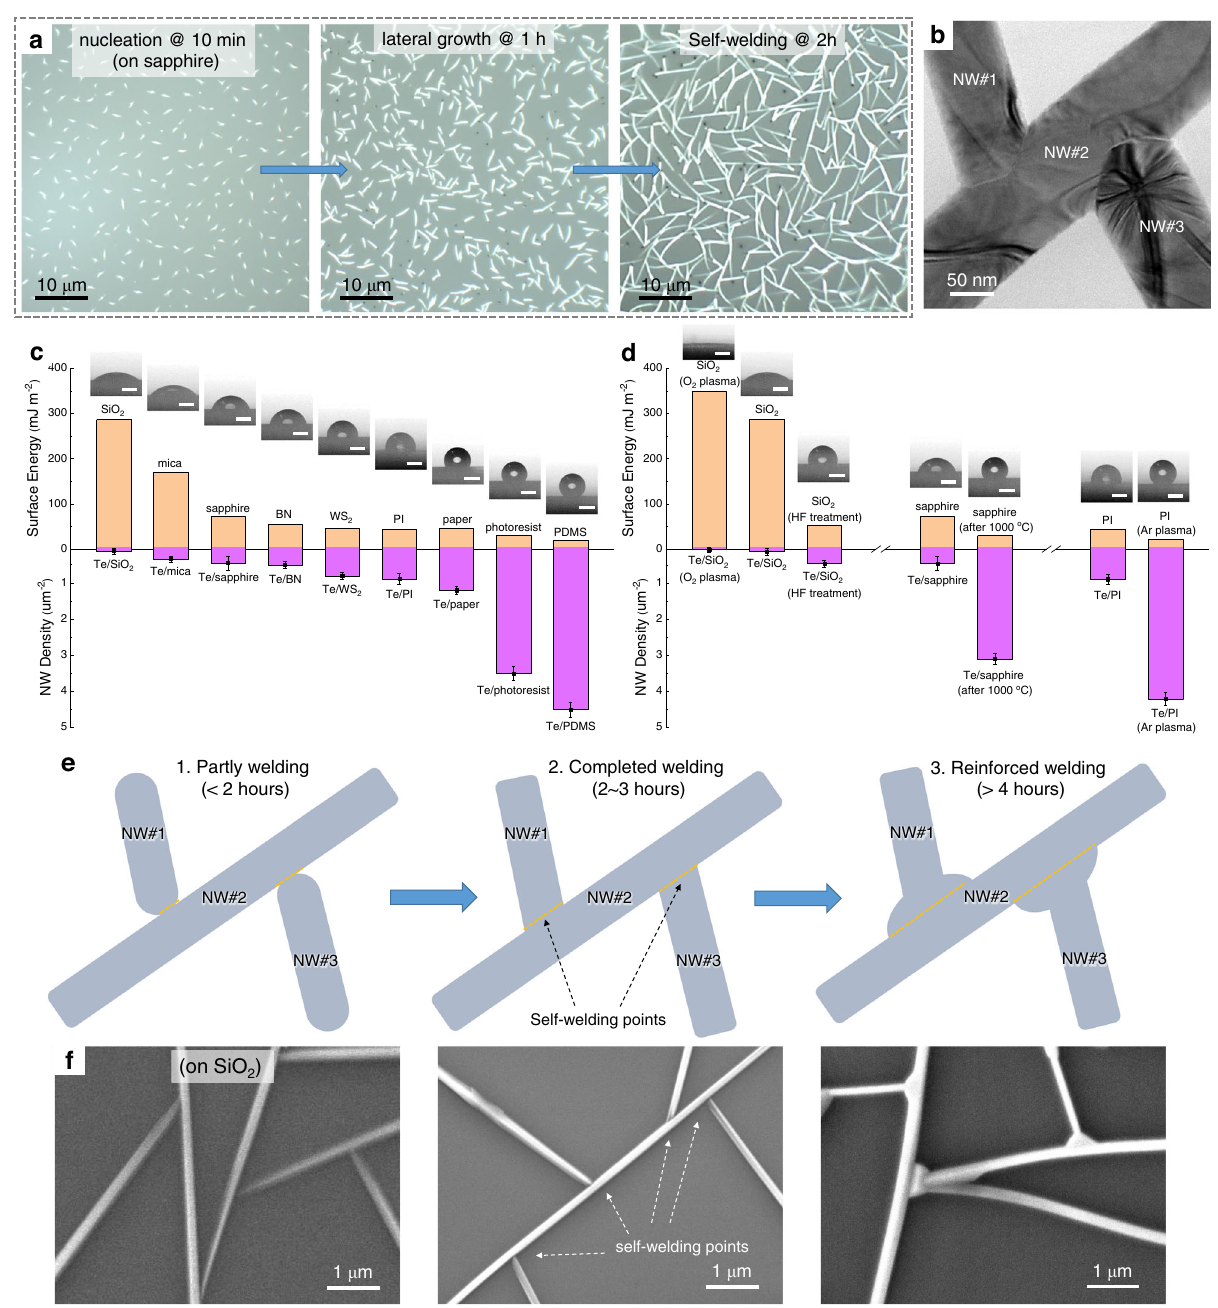
Fig. 2 | Te nanomesh growth. a Optical images of Te nanomeshes grown on sapphire with different growth durations, showing nucleation, lateral growth, and self-welding steps. b Transmission electron microscopy (TEM) images of Te nanomeshes with distinct self-welding regions. c Surface energies of different substrates used in this work and corresponding NW densities of Te nanomeshes after growth. The corresponding references could be found in Supplementary Table 1. The inset shows photographs of water droplets on different substrates.